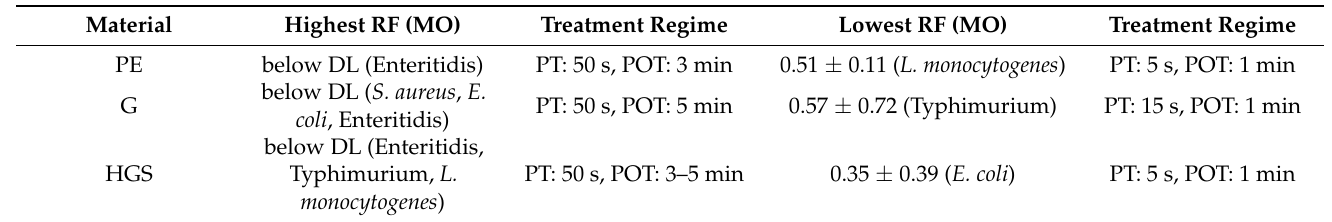
Table 5. Summary of extreme RF values categorized after various surface materials as a substrate for MO